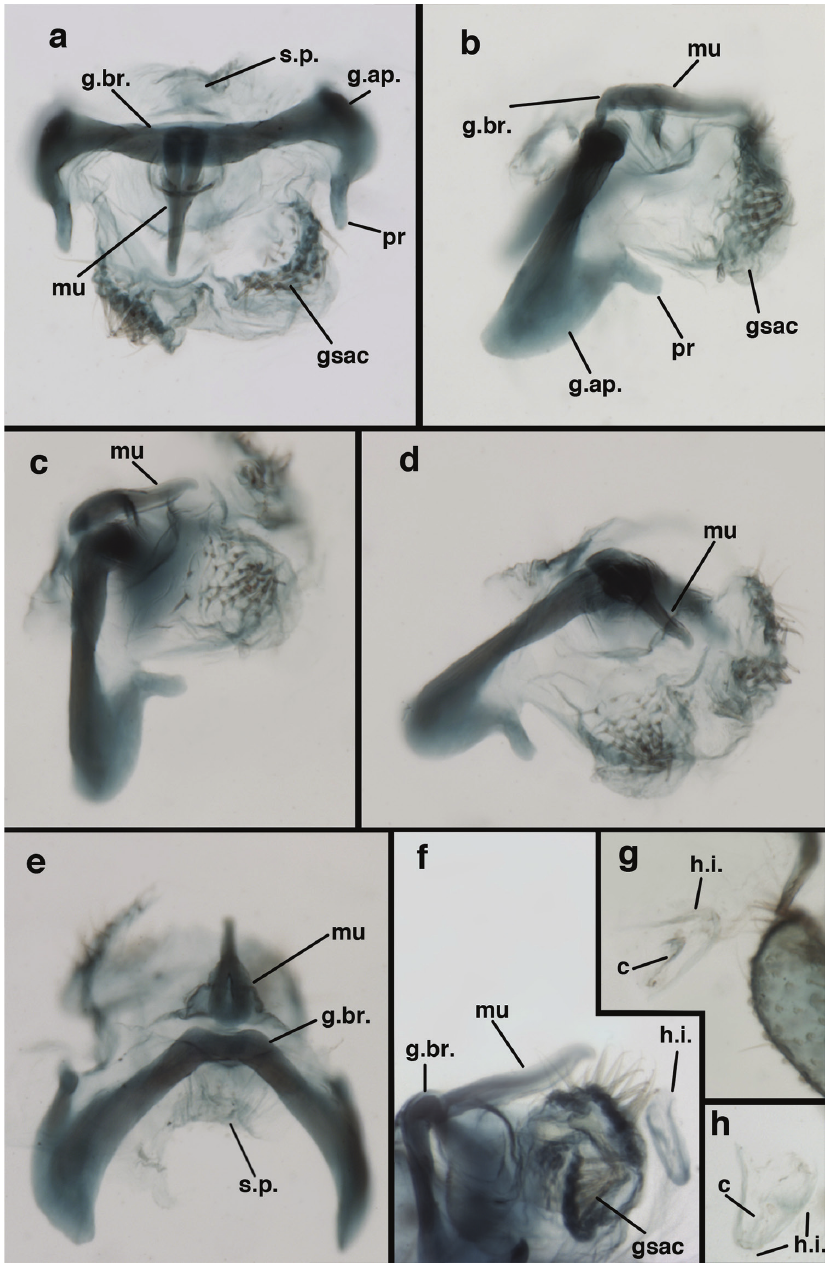
Figure 101. Ungla annulata Navás: Male genitalia, ( a ) gonarcus, dorsal ( b ) gonarcus, lateral ( c ) gonar- cus, posterolateral ( d ) gonarcus, frontolateral ( e ) gonarcus, posterior ( f ) gonarcal complex, partial, lateral ( g, h ) hypandrium internum. c comes g.ap. lateral apodeme of gonarcus g.br. gonarcal bridge gsac gonosaccus h.i. hypandrium internum mu mediuncus pr unarticulated process on frontal margin of gonarcal apodeme s.p. setose subanal plate (Argentina, Salta; a–e SEMC; f FSCA; g